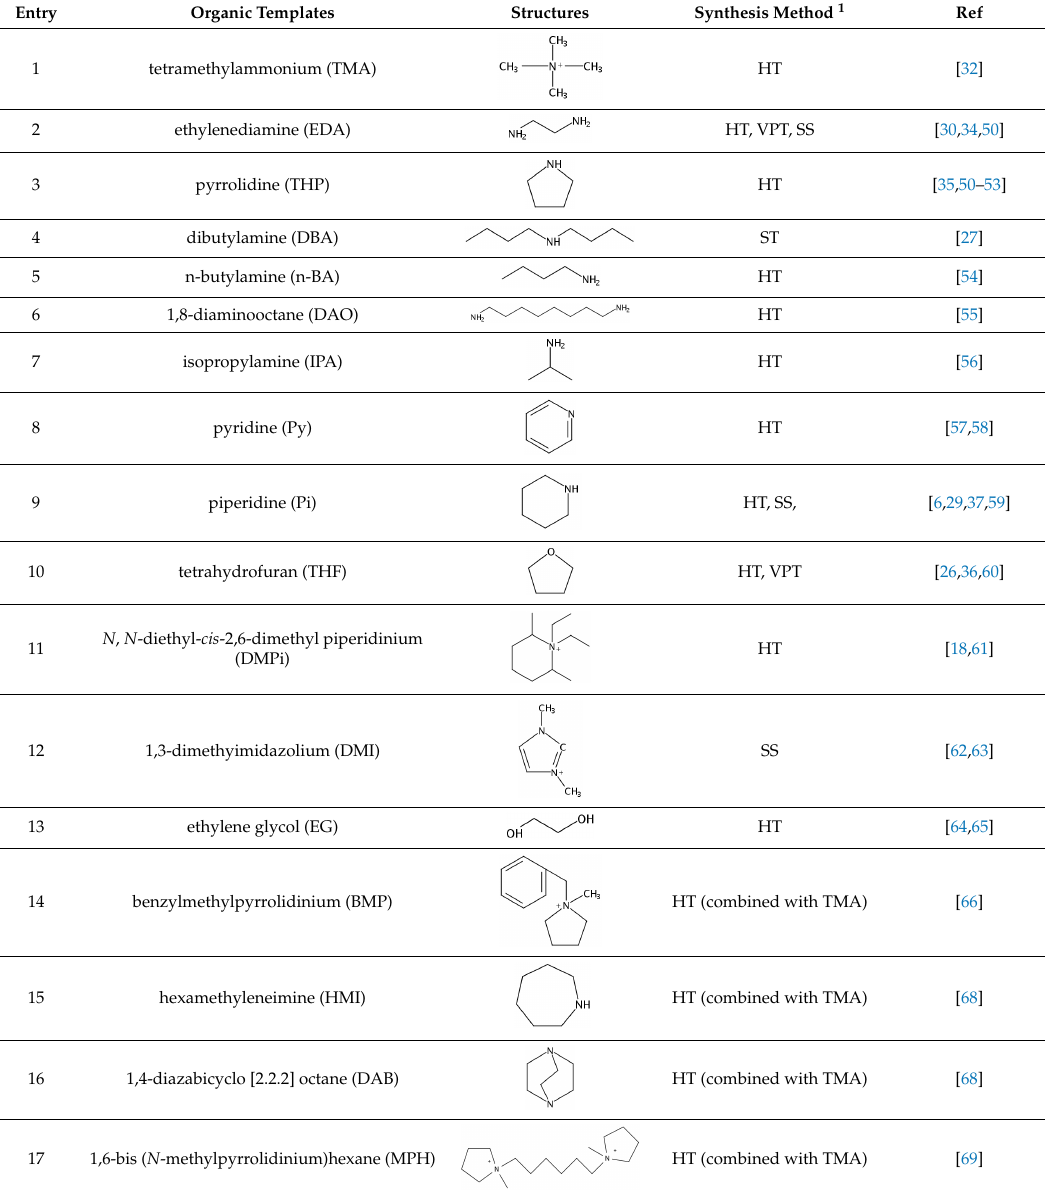
Table 2. Overview of the reported organic templates, their molecular structures and the corresponding synthesis methods. Entry Organic Templates Structures Synthesis Method 1